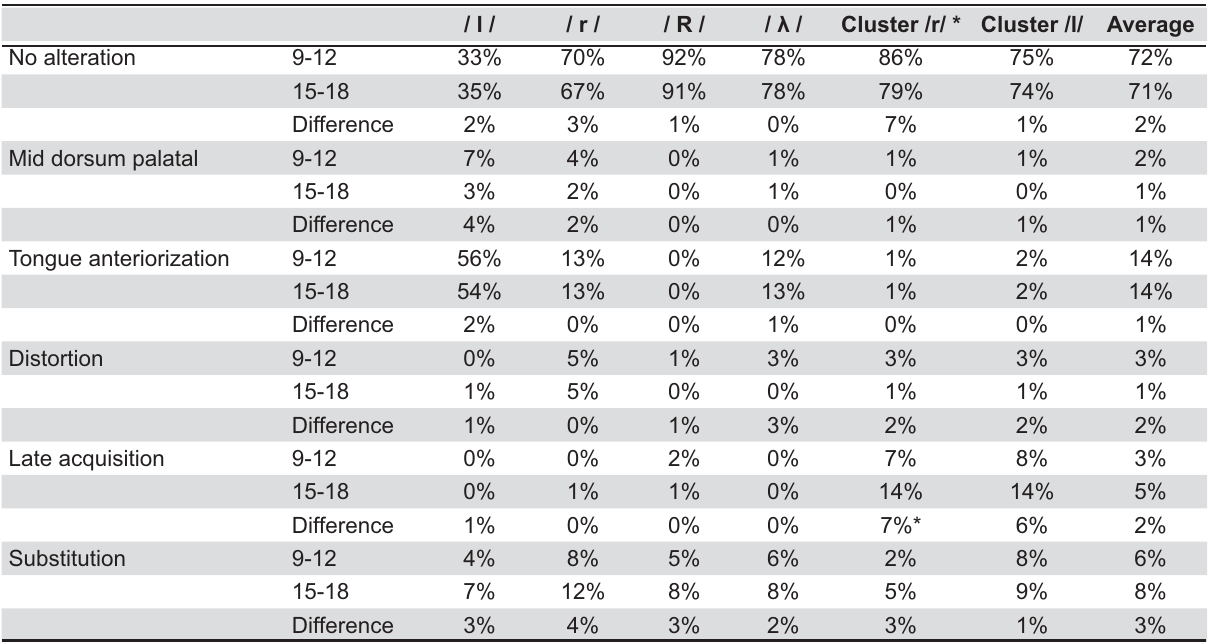
9-12: Samples of patients who received palatoplasty between 9 and 12 months 15-18: Samples of patients who received palatoplasty between 15 and 18 months Difference: difference in % between groups 9-12 and